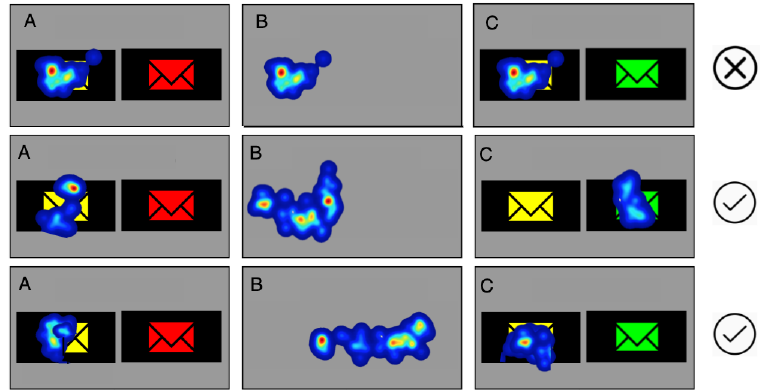
Figure 7. Attracting eyesight to the displayed stimulus. ( A )—first slide, ( B )—empty (middle- gray) screen (2 s), ( C )—next slide. Top : situation where the eyes remain on the picture following the previous task. Middle and Bottom : eyes naturally resting on the image after the stimulus is displayed. To avoid situations where the user’s sight remains on the stimulus of the previously performed task and changes are noticed between images displayed one after another, an empty gray screen was shown for two